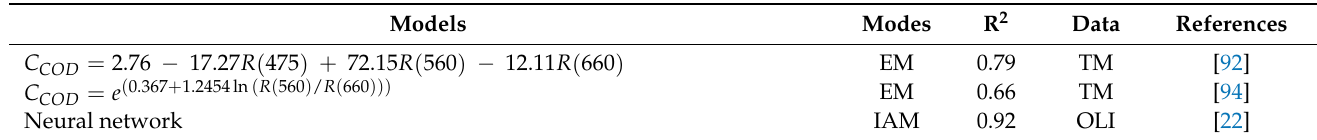
Table 5. Inversion models of COD